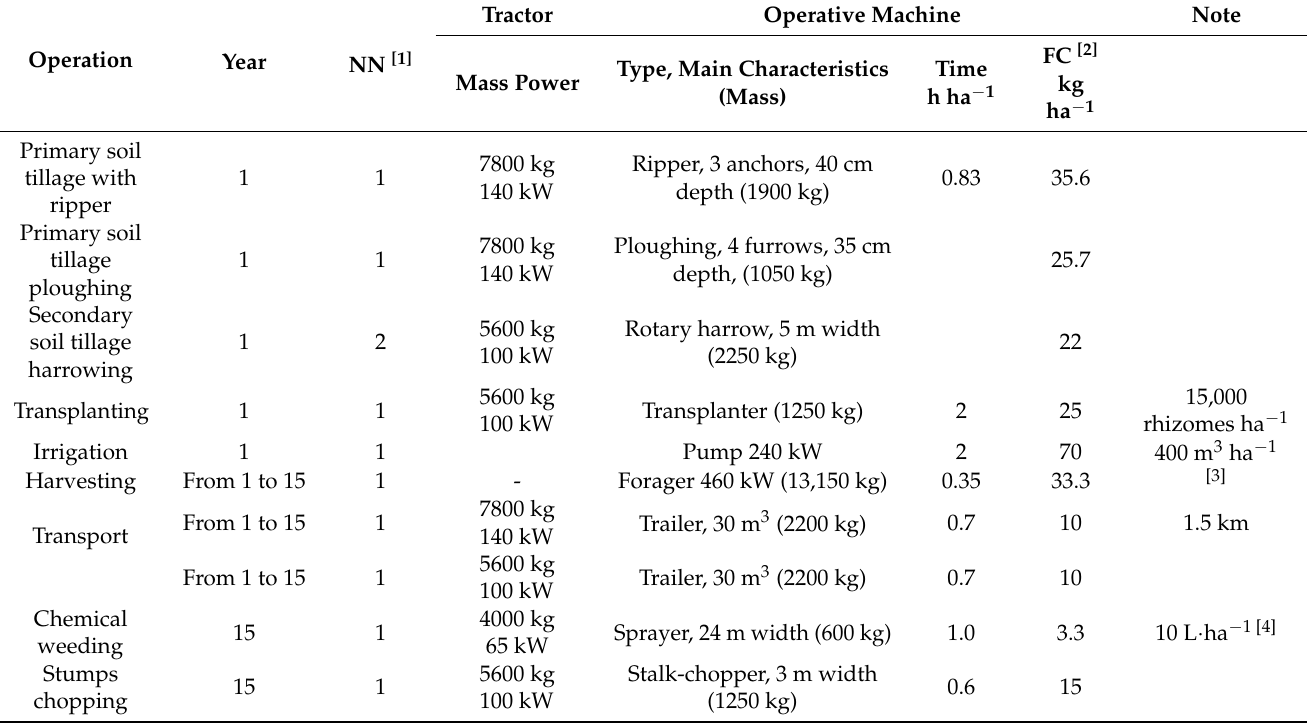
Table 1. Main inventory data about miscanthus cultivation.